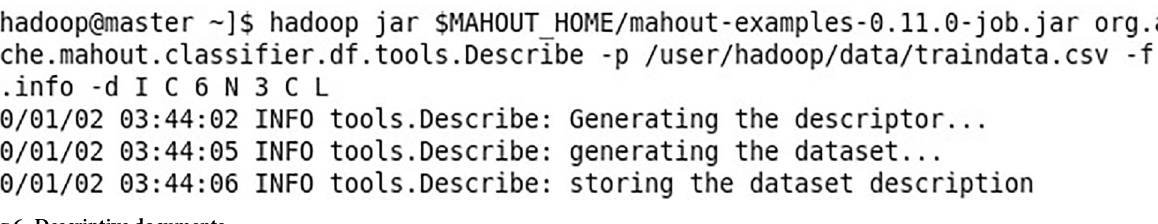
https://doi.org/10.1371/journal.pone.0242458.g006